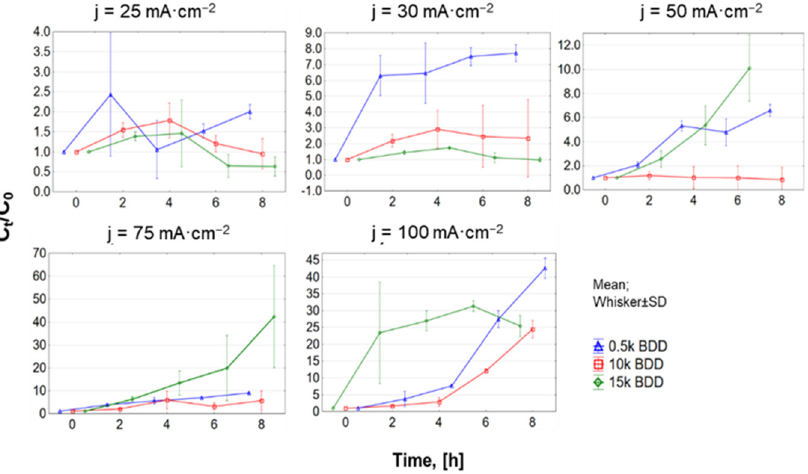
Figure A2. N-NO 2 − changes in LLs with different BDD anodes and current densities (25–100 mA·cm − 2 ).